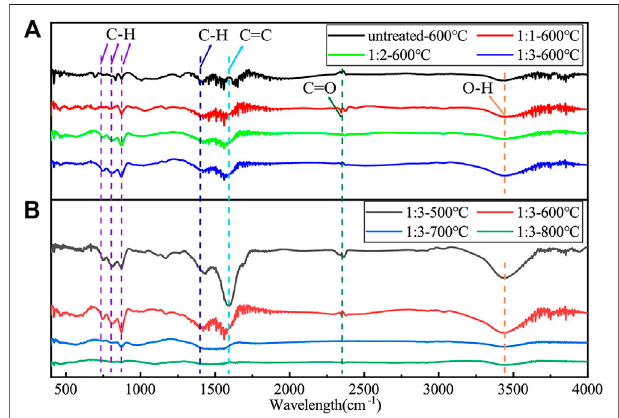
FIGURE2| ComparisonoftheFTIRofCOAsbiochar. (A) Differentsolid- to-liquid ratios at same carbonization temperature (600 ° C); (B) same solid-to- liquid ratio (1:3) at different carbonization